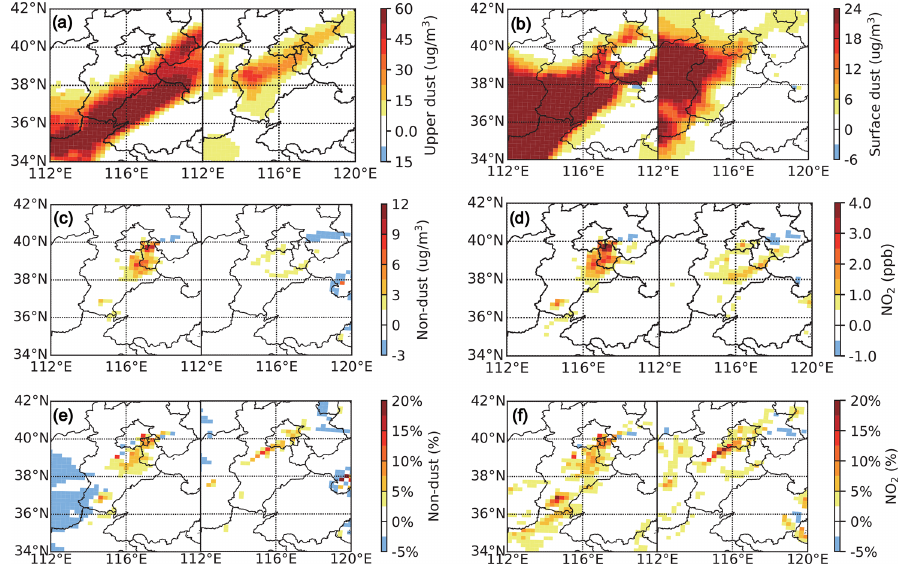
Figure 7. Influence of upper level dust on surface non-dust aerosol in HPI 1 and HPI 2 dissipation stages. Horizontal distribution of (a) upper level suspended dust concentration and (b) surface dust concentration. Difference in (c) surface non-dust particle concentration, and (d) surface NO 2 concentration between the experiments dust_on and dust_off. The percentage change of (e) surface non-dust particle concentration and (f) surface NO 2 concentration between the experiments dust_on and dust_off. The time of each subgraph is the HPI 1 dissipation stage at 13:00 LT on 26 January 2017 (left panels) and HPI 2 dissipation stage at 16:00LT on 4 February 2017 (right panels).